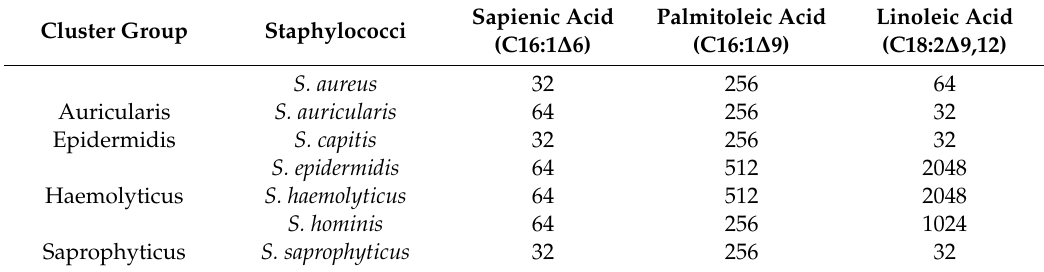
Table 6. Minimum inhibitory concentrations ( µ M) of some antimicrobial fatty